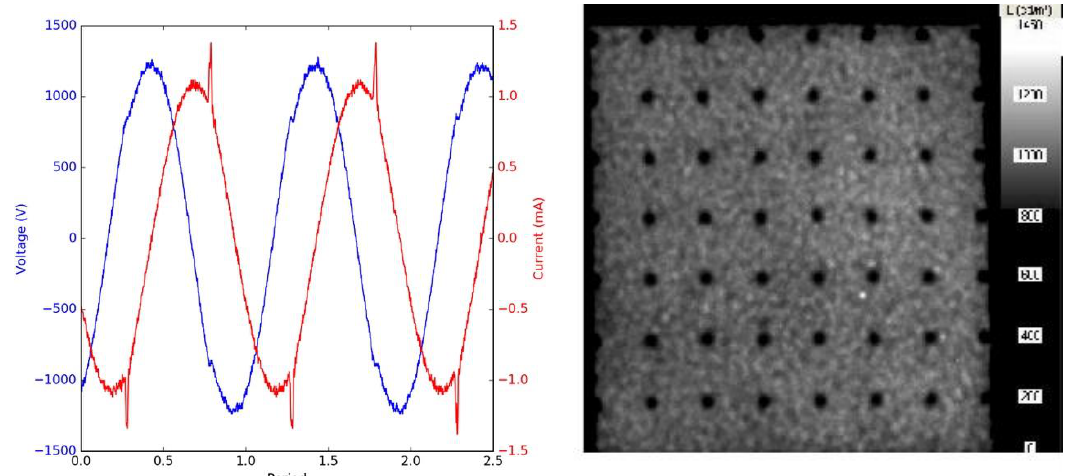
Figure 2. ( Left ) typical current and voltage for Planilum© lamp, Saint Gobain Research, Paris, France (2000 V-20 kHz). ( Right ) luminance measurement for the same conditions [9,10].